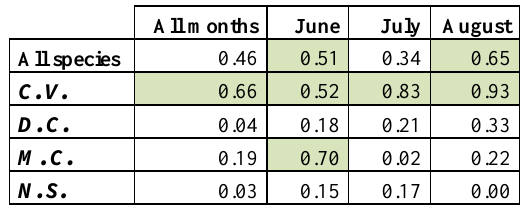
Table 2. The coefficients of determination (R 2 ) produced by the correlations of LCC measured destructively in the laboratory and non-destructively by the CCM-300 chlorophyll meter in the field ( C.V. – Calamagrostis villosa, D.C. – Deschampsia